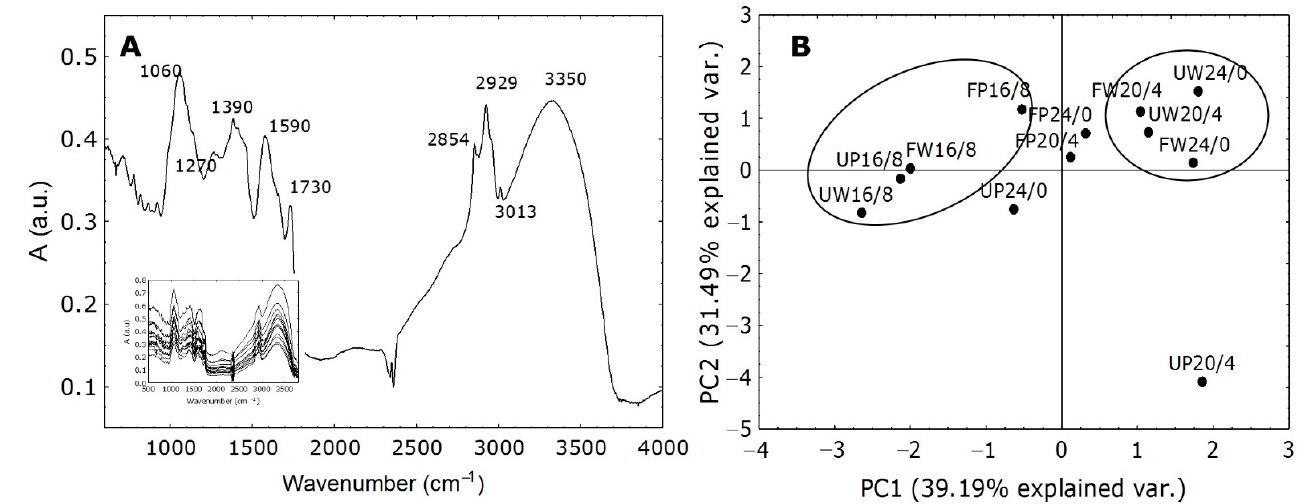
Figure 6. Characteristic bands (range 400–4000 cm − 1 ) of FT-IR spectra measured in the Cannabis samples. ( A ) shows characteristic peaks marked with numbers. The FTIR spectrum was recorded using 12 scans at a resolution of 2 cm − 1 in the wavenumbers range from 400 to 4000 cm − 1 . The insert represents the FTIR spectral analysis in Cannabis cultivars for each treatment. PCA ( B ) represents the explanatory FT-IR variables between and within Cannabis cultivars Finola (F) and USO31 (U) exposed to 16/8, 20/4, and 24/0 photoperiods and grown under white (W) and purple (P) light. Points represent values for each treatment. The analysis provides the score results provided in the insert.